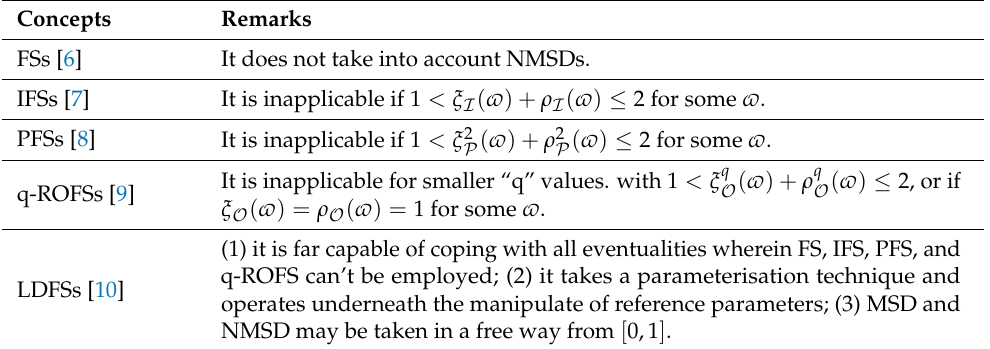
Table 1. Comparative analysis of LDFS with other